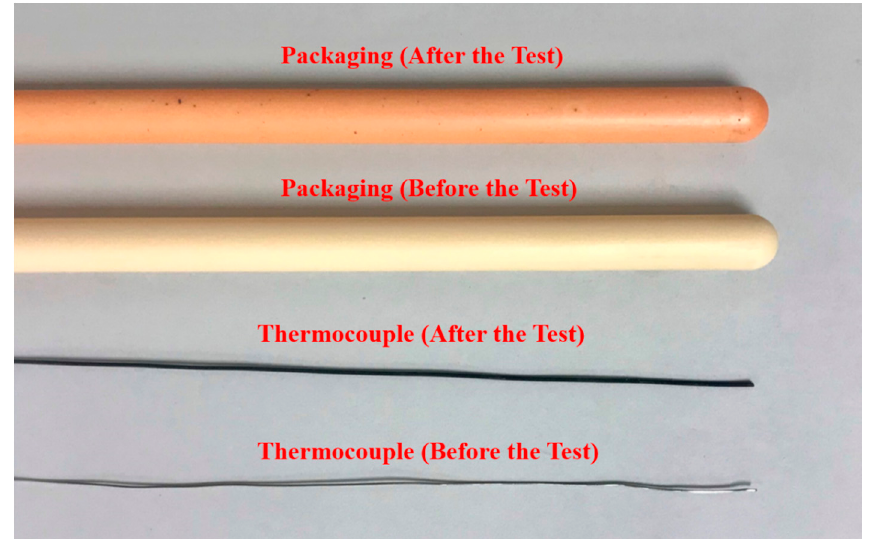
Figure 10. Temperature response of the sensor in a commercial gas-fired boiler over 48 days.